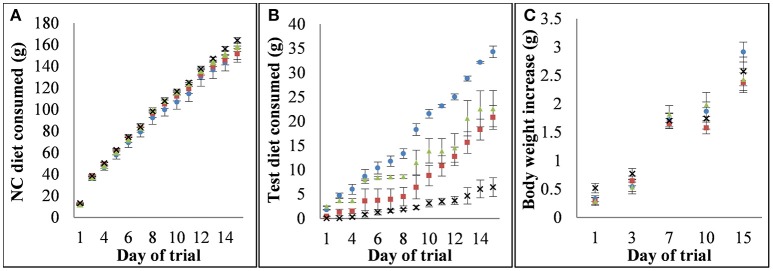
Consumption of each diet and the relationship between diets and weight gain. (A) Cumulative consumption of nutritionally complete (NC) partner diets for each diet group, (B) cumulative consumption of test diets for each diet group, (C) cumulative weight gain for each diet group. Diet groups are defined by their test diet as follows: blue circle - starch dough (SD), red square - starch dough containing nisin (SD-N), green triangle - starch gel (SG), black cross - starch gel containing nisin (SG-N).